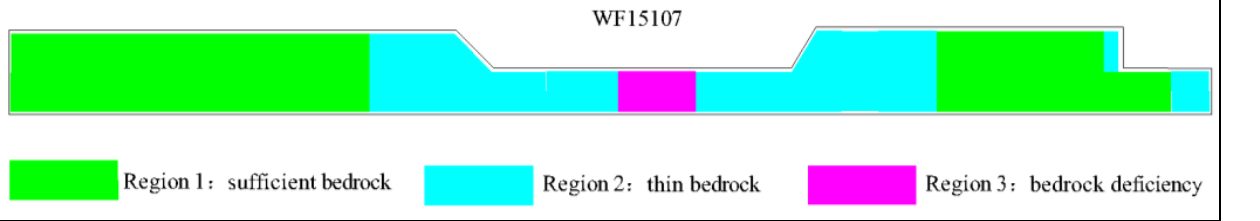
Figure 6. Schematic diagram of different bedrock thickness zones.